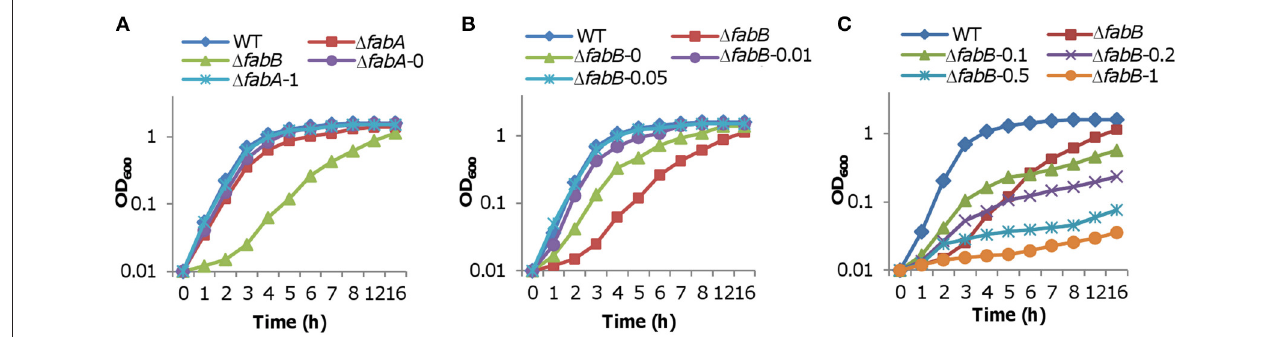
FIGURE 5 | Influence of FabA and FabB overproduction on growth. Expression of fabA and fabB at varying levels was achieved by using the IPTG-inducible P tac within pHGE-P tac , which is slightly leaky in S. oneidensis . The vector with the fabA and fabB construction was introduced in the respective deletion strains by conjugation. (A) Influence of FabA overproduction on growth. Experiments were conducted in the absence and presence of IPTG from 0.05 to 1mM (given after strain name). Given that growth of 1 fabA and the wild-type with all levels of IPTG was indistinguishable, results with 1mM were shown only. (B,C) Influence of FabB overproduction on growth. Experiments were conducted in the absence and presence of IPTG from 0.01 to 1mM (given after strain name). In all panels, error bars (less than 10% of the average), representing SD from three independent experiments, were omitted for